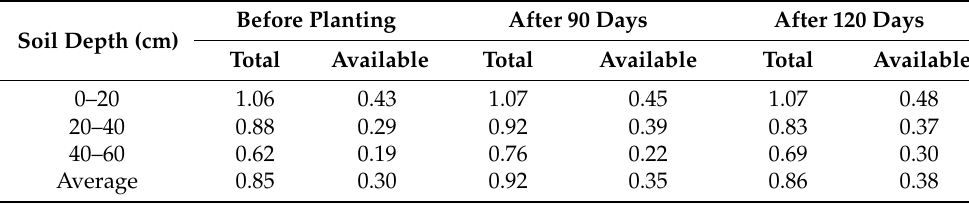
Table 2. Selenium concentrations (mg kg − 1 ) monitoring in the studied area. Before Planting After 90 Days After 120 Days Soil Depth (cm) Total Available Total Available Total